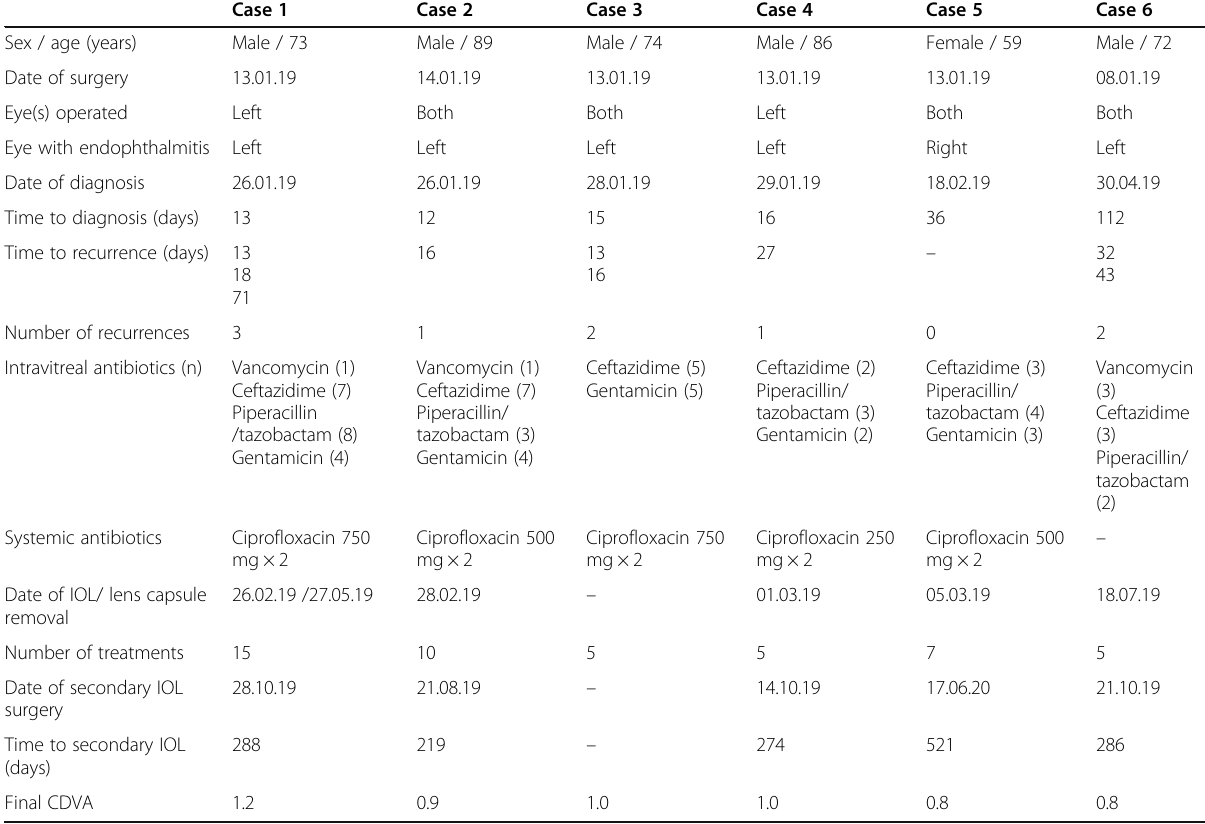
Table 1 Demographics, clinical course and treatment in cases with Burkholderia contaminans